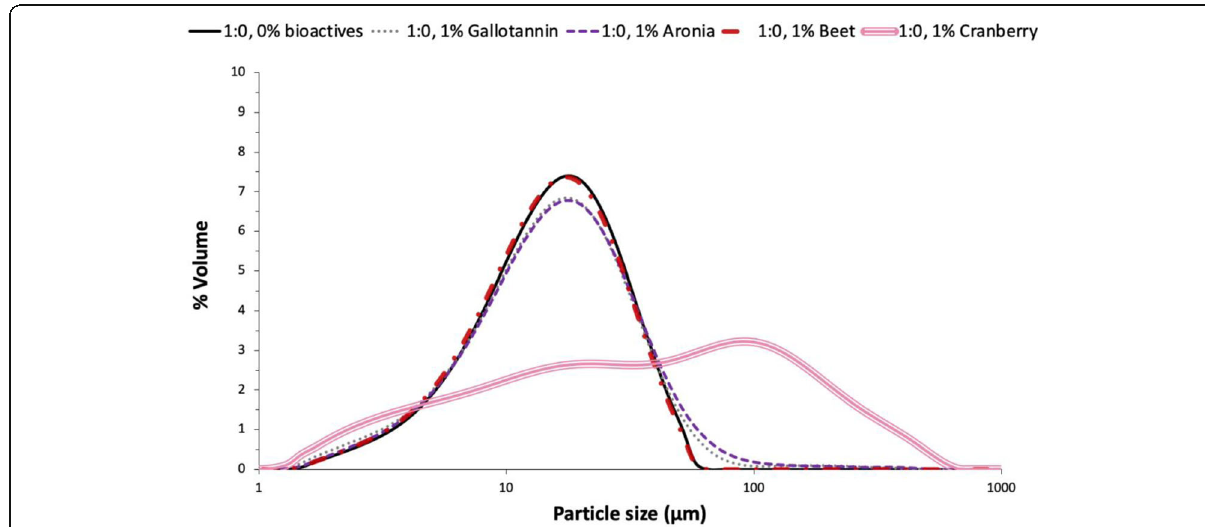
Fig. 4 Particle size distributions of feed dispersions comprised of 1:0 WPI:sucrose ratios with 0% bioactives and 1% bioactives from pure gallotannin, Aronia berry, beet, and cranberry extracts at 25 °C; ( n =